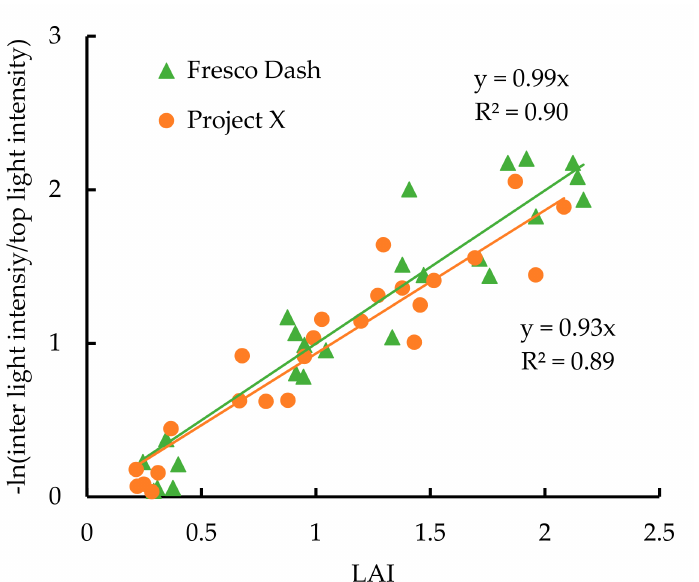
Figure 3. Extinction coefficient ( k ) of two cucumber cultivars. The k values were 0.99 and 0.93 in “Fresco Dash” and “Project X”, respectively. The values were measured at 10:30–11:00 a.m. on 24 March 2020. ( R 2 = 0.90 for Fresco Dash, R 2 = 0.89 for Project X; p < 0.001). The R 2 values were 0.90 and 0.89 in FD and PX, respectively, indicating significant correlations. The LUEs were significantly correlated with daytime CO 2 concentrations (Figure 4; R 2 = 0.71 in FD, 0.84 in PX; n = 24; p < 0.001). Based on 95% confidence intervals, no significant differences in LUEs were observed between the two cultivars.